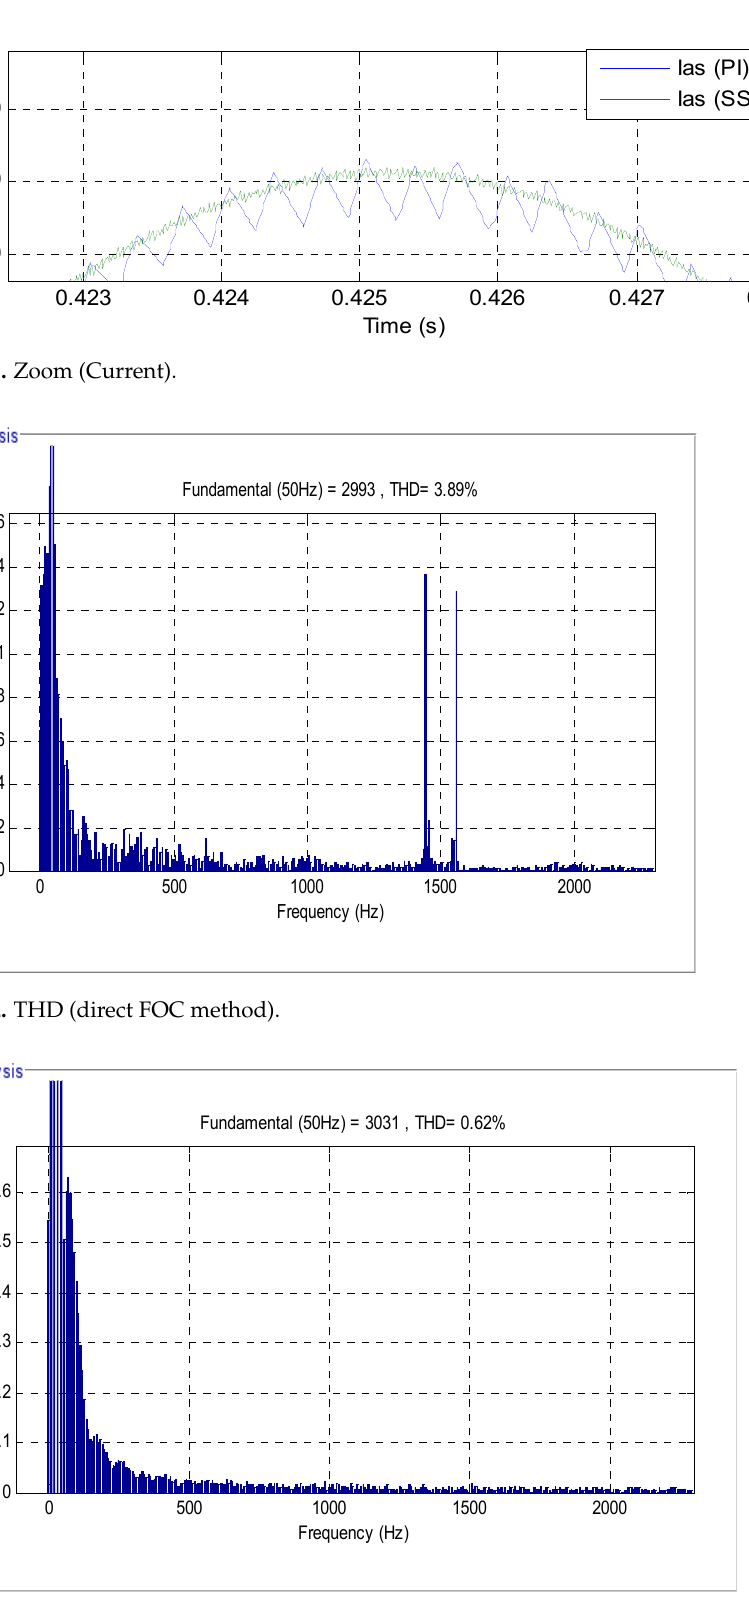
Figure 23. THD (direct FOC-SSMC control).